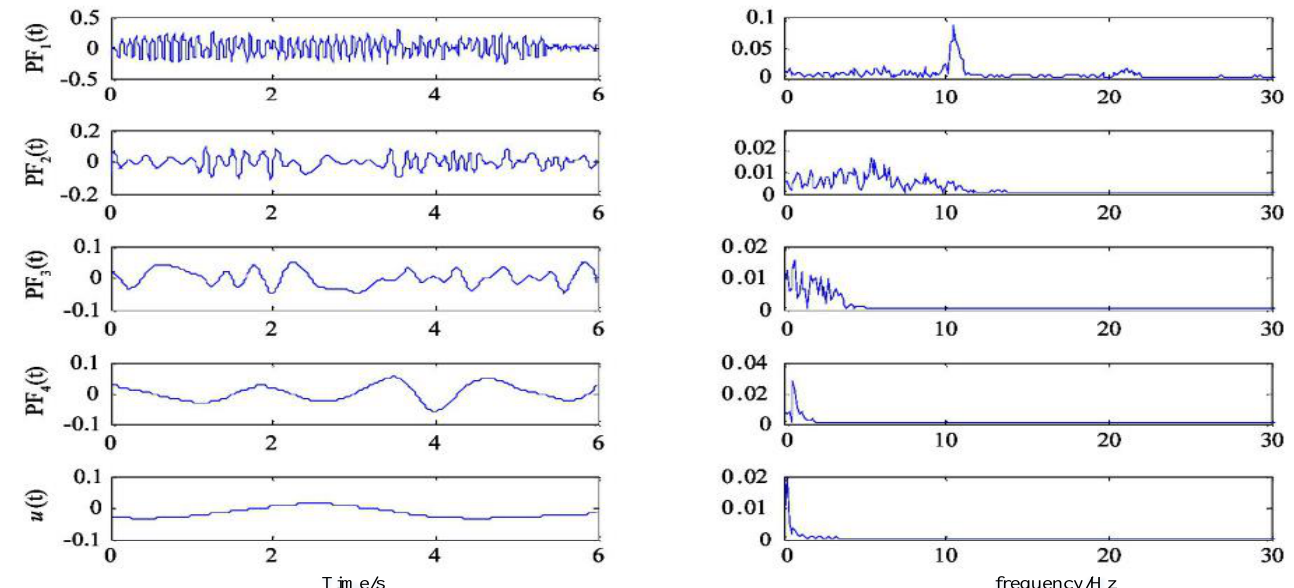
Figure 3. Time-frequency diagram of each PF component of EEG signal (C4 channel) decomposed by